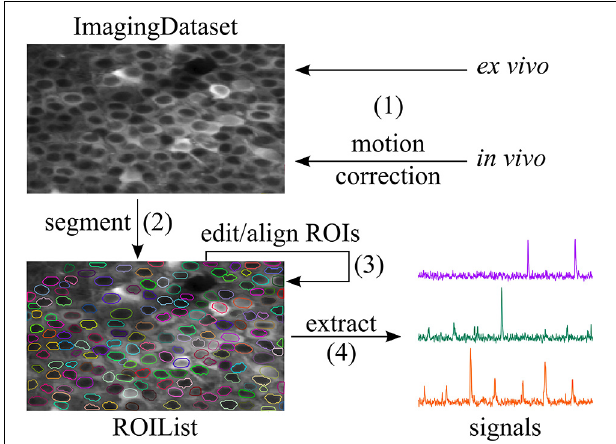
FIGURE 1 | Workflow supported by SIMA. (1) An ImagingDataset object is first created either directly from the raw data or from the output of the motion correction algorithm. (2) ROIs are generated by automatic segmentation. (3) The ROI Buddy GUI can be used to edit the automatically generated ROIs and to automatically register ROIs across multiple datasets. (4) Dynamic fluorescence signals are extracted from the imaging data and